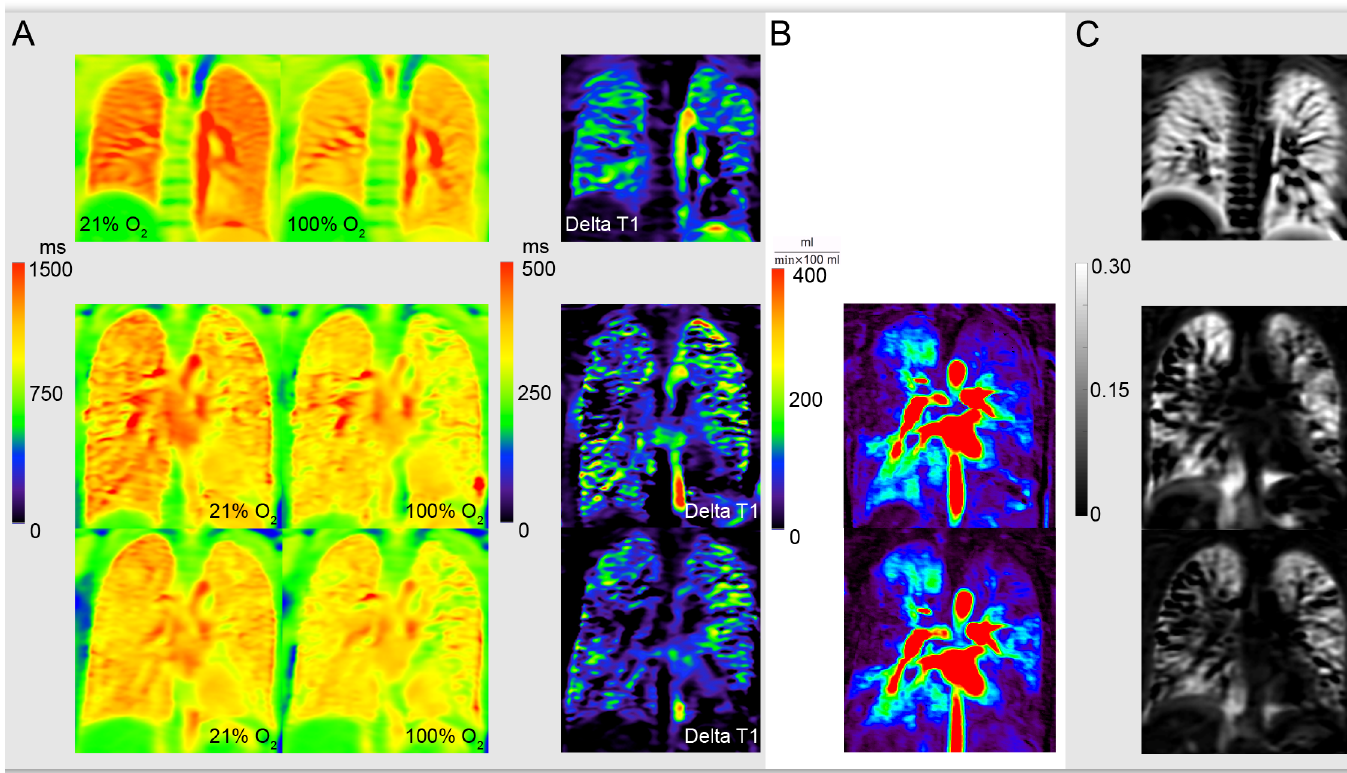
Fig 3. Comparison of a healthy volunteer and a CF patient. First row: healthyvolunteer, second row: pre treatment, third row: post treatment; A: room air T1 map, oxygen enhancedT1 map and delta T1 map; B: Calculatedperfusionmap by using a pixel-by-pixel deconvolution analysis; C: Fractional ventilation map. Regardingthe healthyvolunteervalues are homogeneously distributedthroughoutthe whole lungs. In comparisonto that in the CF patient values are lower and more heterogeneous distributed. Hypoventilated and hypoperfused areas can be seen in all three methods, most prominentin the right upper lobe. After treatment an improvement of ventilationand perfusion is not observed.